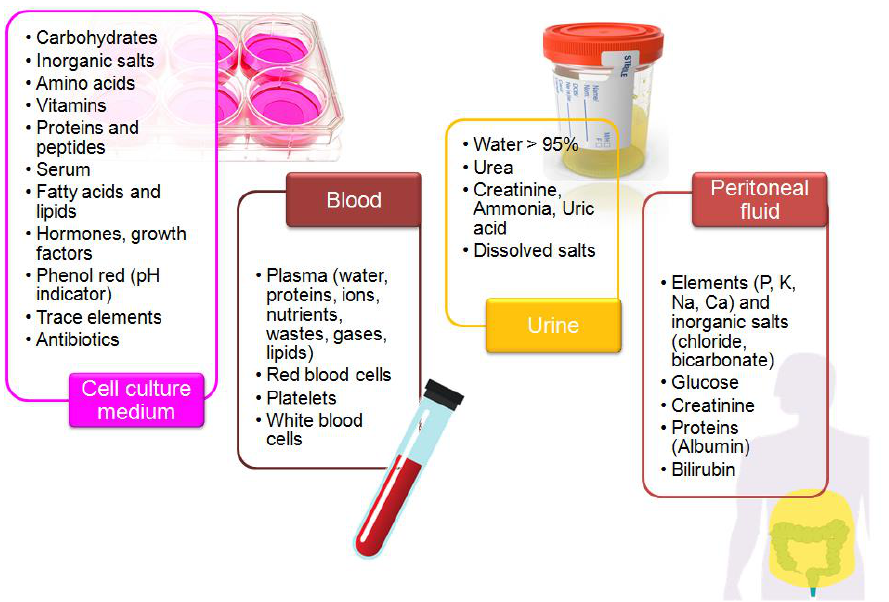
Figure 2. Composition of the selected biological matrices used in studies on tryptophan metabolism.